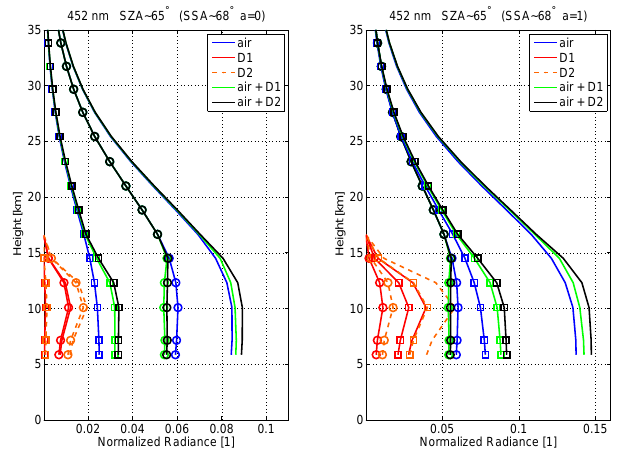
Fig. 3. As in Fig. 1 but at 452nm.